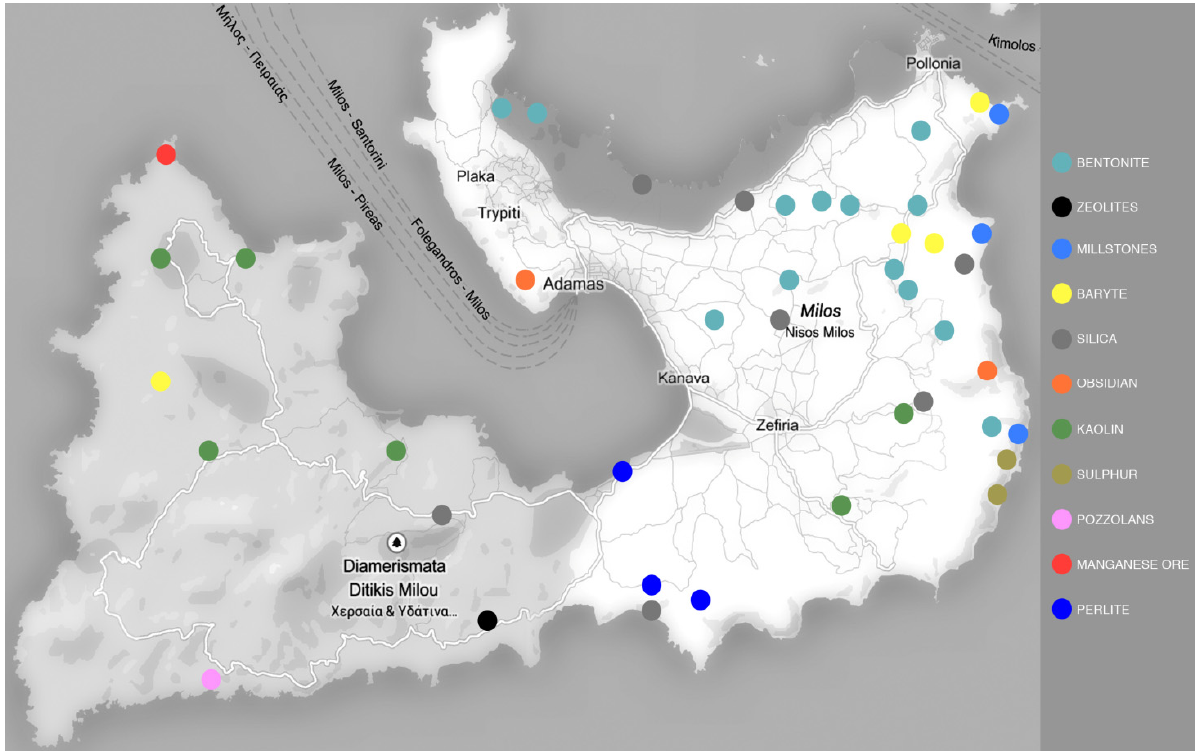
Figure 1. Historical and modern mining locations of mineral products in Milos. Current production includes mining locations of bentonite and